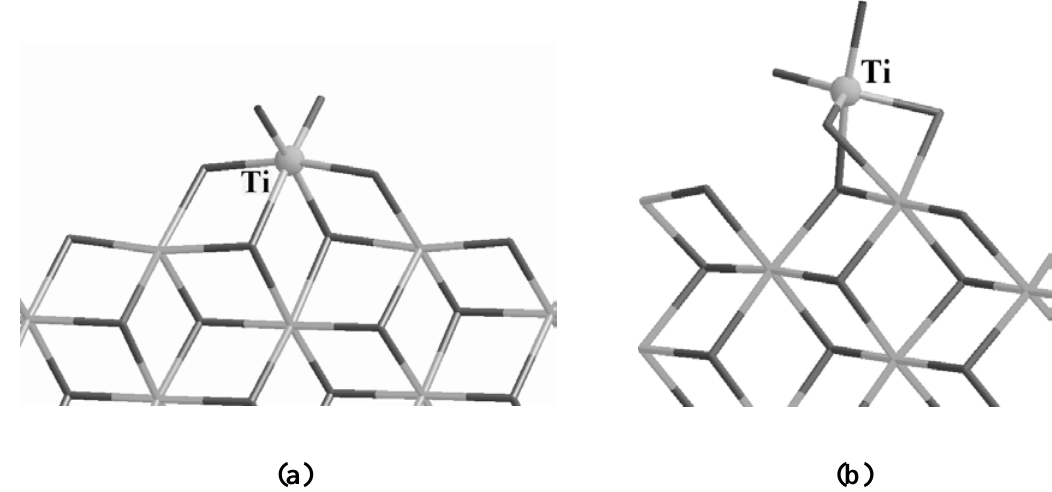
Figure 2. Corradini’s Ti mononuclear site (a) and the 5-fold Ti site obtained by simulating the deposi- tion of TiCl on the (110) surface. The Ti atom is labeled and evidenced as a ball for clarity. The gray 4 scale code is the same as in Figure